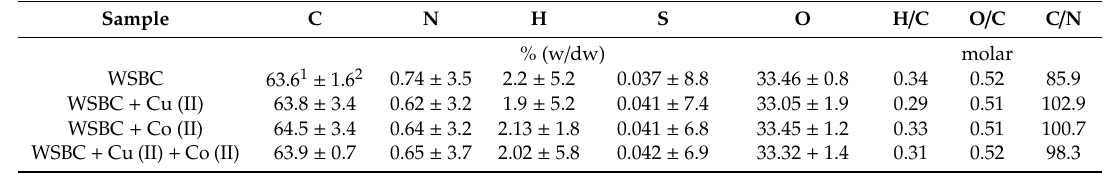
Table 2. Elemental composition of pure and spiked with metal salts wheat straw biochar.